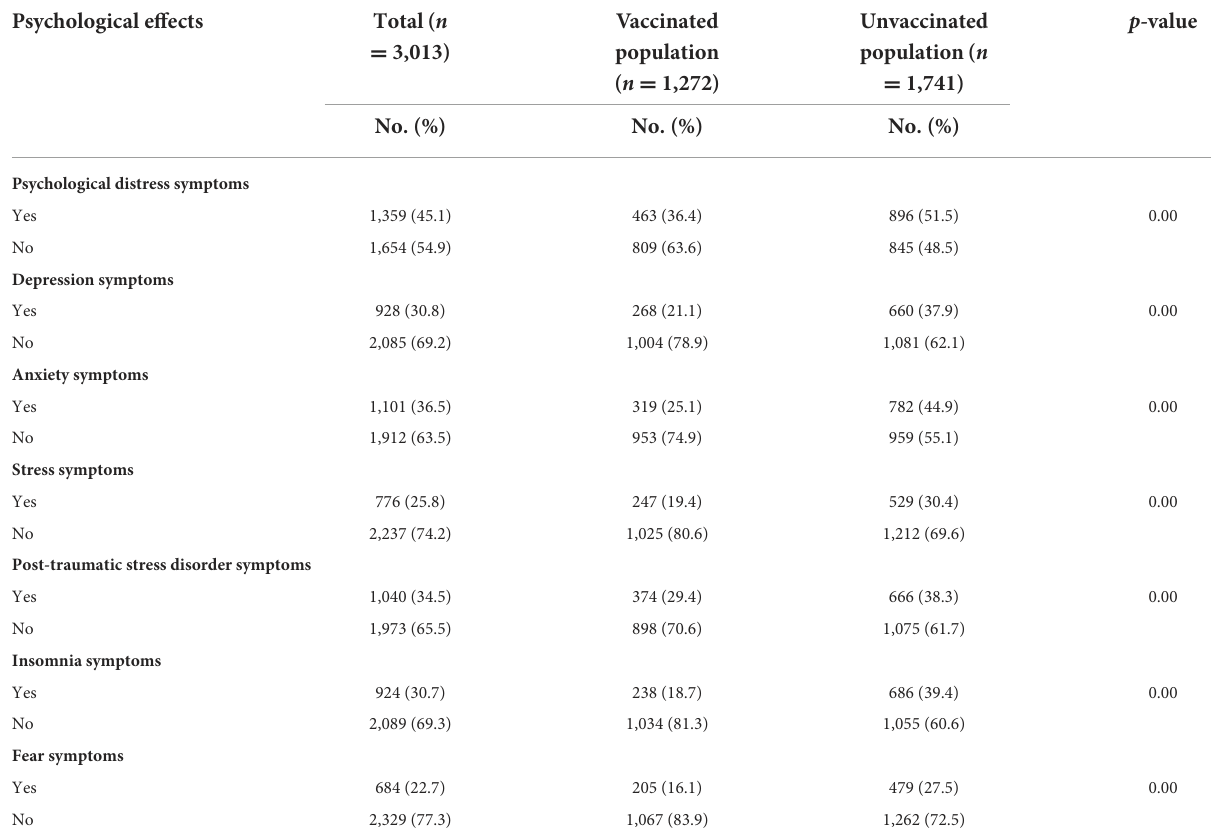
TABLE 3 The prevalence of psychological effects among vaccinated and unvaccinated populations against COVID-19 infection. Psychological effects Vaccinated